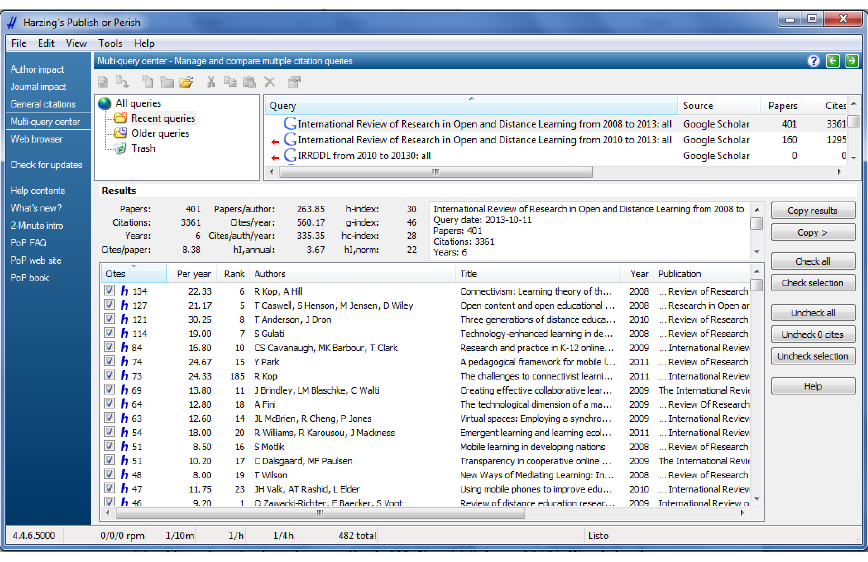
Figure 1. Journal impact analysis in Publish or Perish software